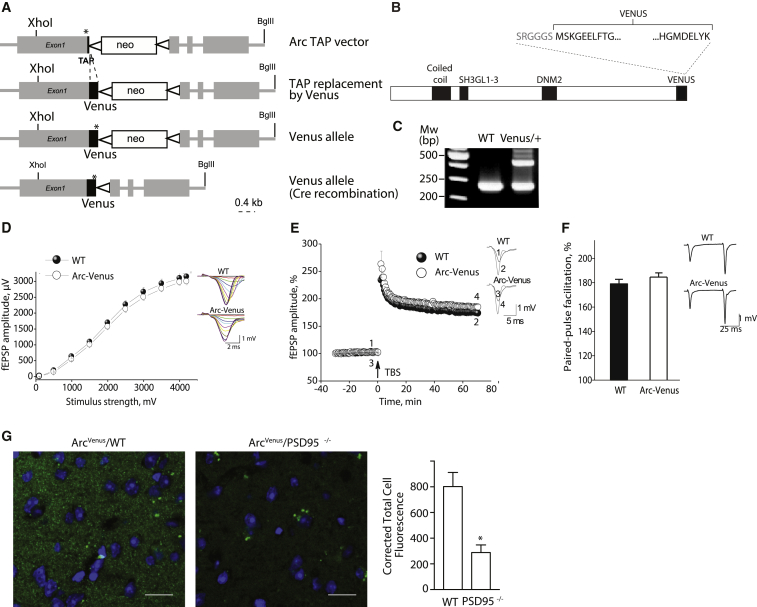
Generation of Venus-Tagged Arc Knockin Mice(A) The Venus sequence was inserted before the stop codon of the protein using the TAP vector as template. The cross of both knockin mice with a transgenic Cre-expressing mouse line deleted the neo resistance cassette by recombination between loxP-sites. Asterisk, stop codon (TAA) of the coding sequence; thick black line, TAP and Venus tag sequence, as indicated; triangle, loxP site.(B) Structure of the Venus-tagged Arc regions as in Figure 1B.(C) PCR amplification of WT (bottom band) and Arc Venus-targeted alleles (top band). Venus/+, heterozygous for Venus-tagged Arc.(D) Input-output relationships illustrate averaged field excitatory postsynaptic potential (fEPSP) amplitudes in slices from ArcVenus/Venus (n = 26, N = 8) and WT mice (n = 22, N = 8) in response to stimulation of Schaffer collaterals. Areas under input-output curves were not significantly different between genotypes (F(1,13.06) = 0.499; p = 0.493).(E) Normalized magnitude of LTP 60–65 min after LTP induction did not differ significantly in mutant mice (185% ± 4%; n = 25, N = 8; F(1,11.64) = 2.92; p = 0.114) relatively to their WT counterparts (174% ± 4%; n = 22, N = 8).(F) Paired-pulse facilitation was not statistically different (F(1,11.08) = 1.372, p = 0.266) in ArcVenus/Venus animals (n = 26, N = 8) compared with their WT littermates (n = 22, N = 8). Data are presented as mean ± SEM, with n = slices and N = mice.(G) Representative section of ArcVenus mouse brain crossed with WT (left) and PSD95−/− (right) mice. Shown is a bar chart of the total cell fluorescence corrected by the area and the background signal. Scale bars, 15 μm.